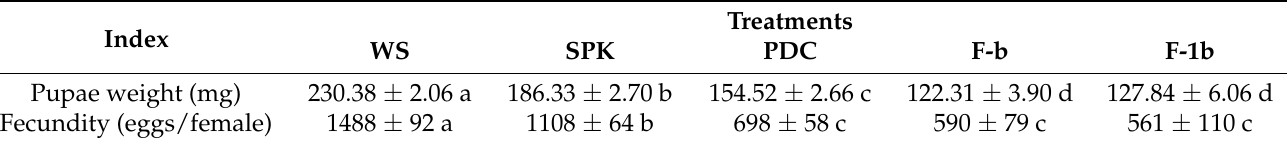
Table 2. Pupal weight and fecundity of the FAW fed on different wheat tissues in the laboratory.